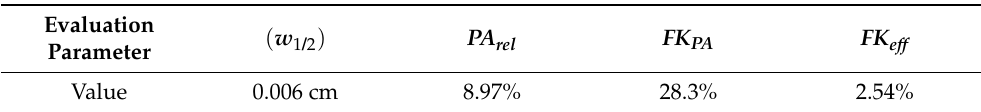
and 2.54%, respectively. Table 4. Treatment evaluation parameters after 60 min of treatment with intraperitoneal injection by the traditional method.